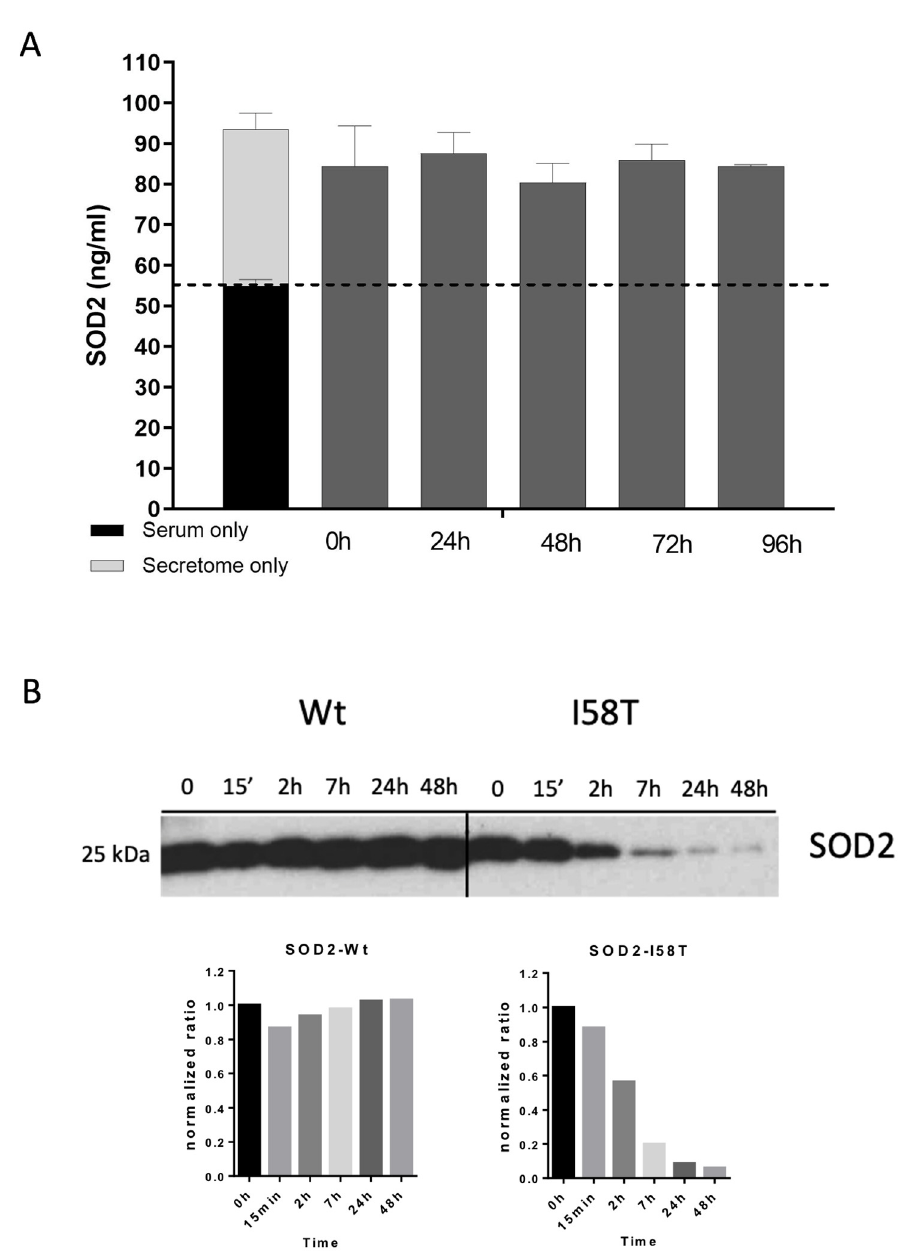
Figure 4. SOD2 is stable within human serum. ( A ) SOD2 levels were stable when incubated in human serum. Secretome from BT549 cells was spiked into human serum and incubated at 37 ◦ C for 0 h (as initial control), 24 h, 48 h, 72 h, and 96 h. The levels of SOD2 were assessed by ELISA. The dashed line in the plot indicates the endogenous levels of SOD2 in the human serum used. ( B ) SOD2-I58T was degraded in human serum while SOD2-WT was resistant. Secretomes expressing WT-SOD2-histag or SOD2-I58T-histag were spiked into human serum and incubated up to 48 h. The two tagged proteins were purified using nickel beads at different time points (0 h, as control, 15 ′ , 2 h, 7 h, 24 h, 48 h). An immunoblot was performed to detect SOD2 levels. Quantification of the immunoblot bands was performed with Image J. Protein levels were normalized to the control condition of each experiment.